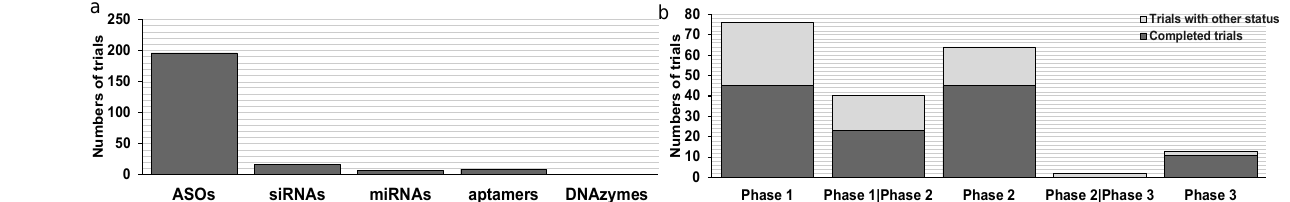
Figure 1. Summary of clinical trials for oligonucleotide therapeutics in oncology. ( a ) Numbers of trials for different types of oligonucleotide therapeutics; ( b ) Trials status. Number of trials were retrieved from Supplementary Materials.